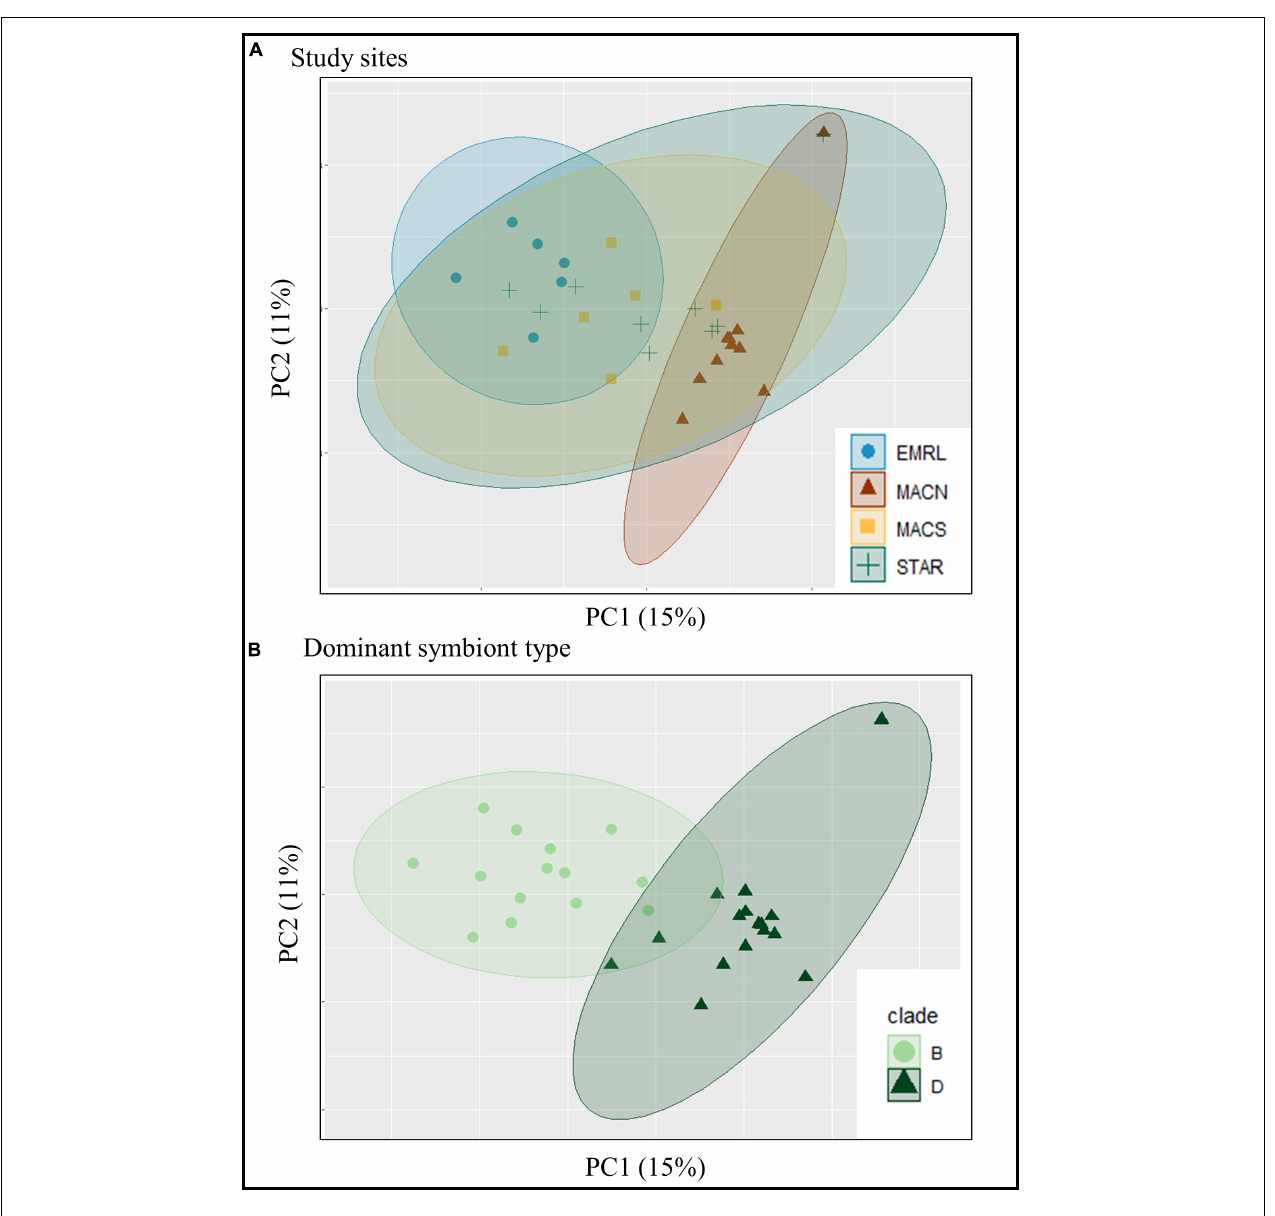
FIGURE 3 | The similarity of 31 individuals of P. strigosa based on the transcriptome expression profiles (expression of 39,321 protein-coding sequences). Samples are color and symbol coded by the (A) study location and (B) dominant symbiont type. The ellipses represent the 95% clustering confidence